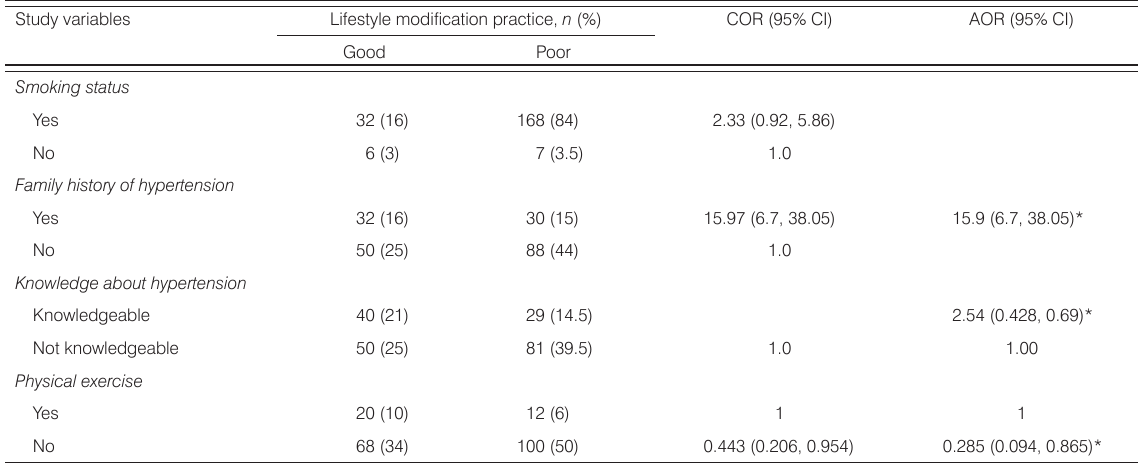
Table 4. Factors associated with lifestyle modification practice among hypertensive